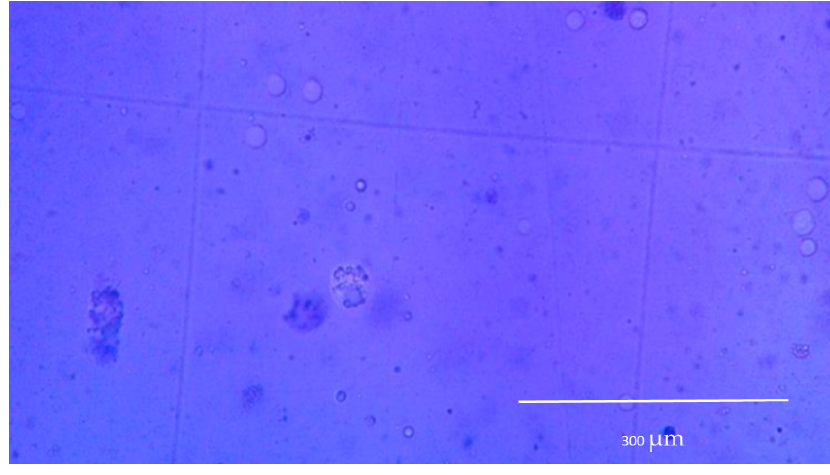
Figure 9. Cell culture after 5 days.